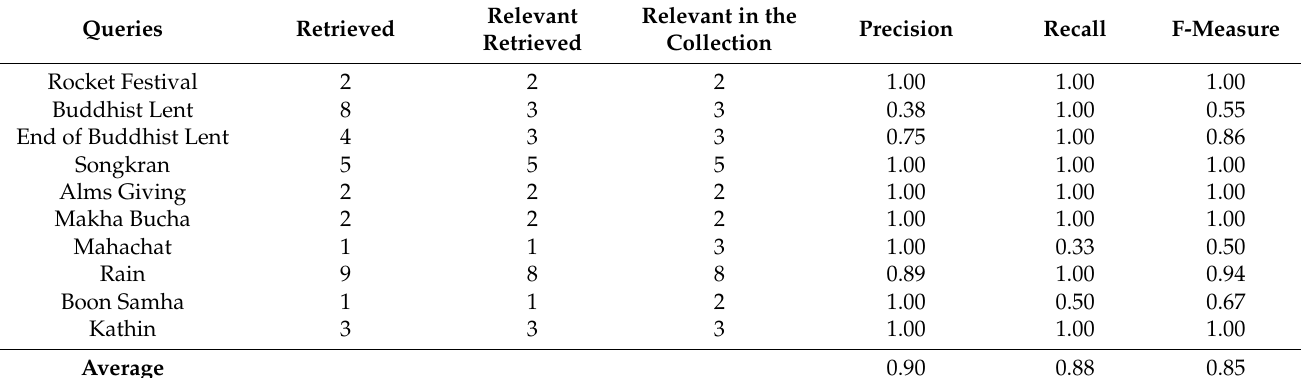
Table 4. The performance of the semantic information retrieval system with keyword